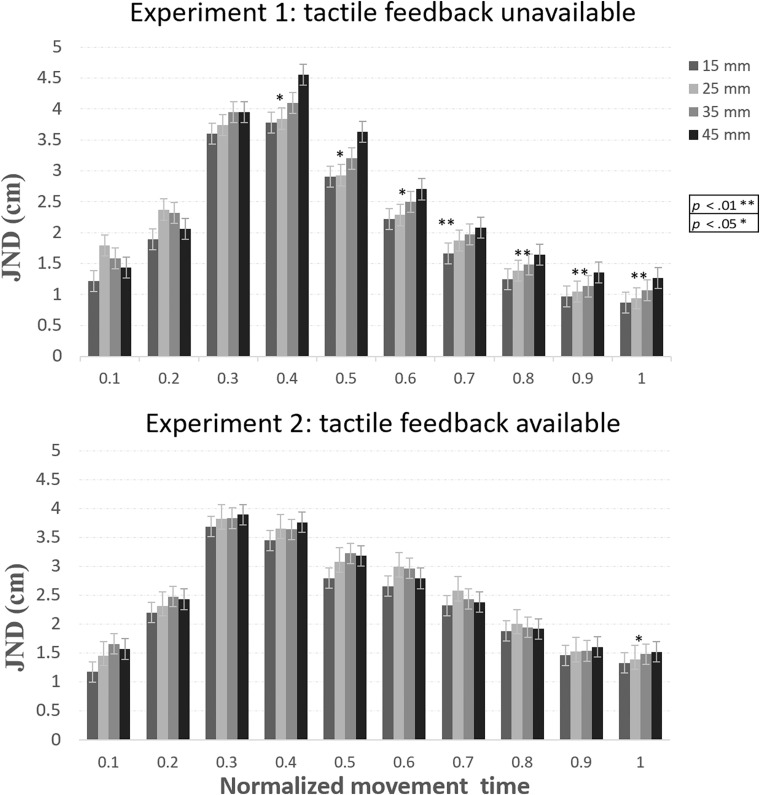
Average JNDs across the three blocks in Experiments 1 and 2. In Experiment 1, JNDs adhered to Weber’s law throughout most stages of the movement. Conversely, in Experiment 2, Weber’s law was violated in most stages of the movement. Error bars represent confidence intervals in repeated measures ANOVAs (Jarmasz and Hollands, 2009). *p < 0.05; **p < 0.01.